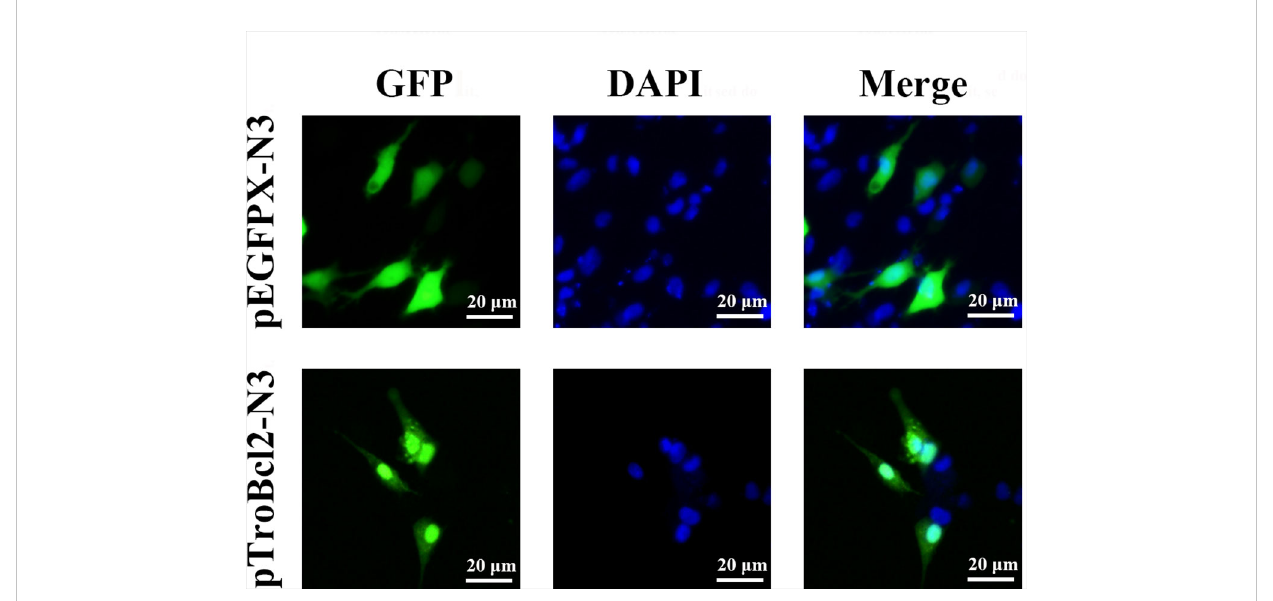
FIGURE 3 Subcellular distribution of TroBcl2. Golden pompano snout (GPS) cells were transiently transfected with plasmid pTroBcl2-N3 or pEGFPX-N3 for 48 h, and then examined using an inverted fl orescence microscope DMi8. DAPI staining shows the nuclei of